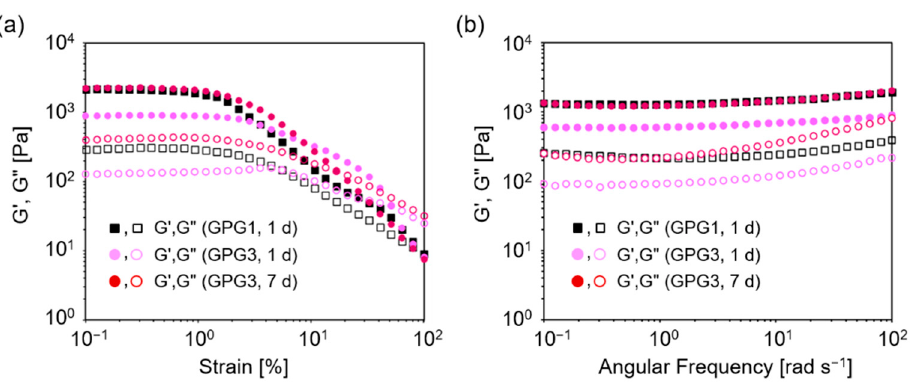
Figure 3. Rheological properties of hydrogels containing GPG1 and GPG3 at 0.5 wt%. ( a ) Strain sweep (1 Hz) and ( b ) frequency sweep (1% strain). The solid and open symbols represent G’ and G”, respectively.